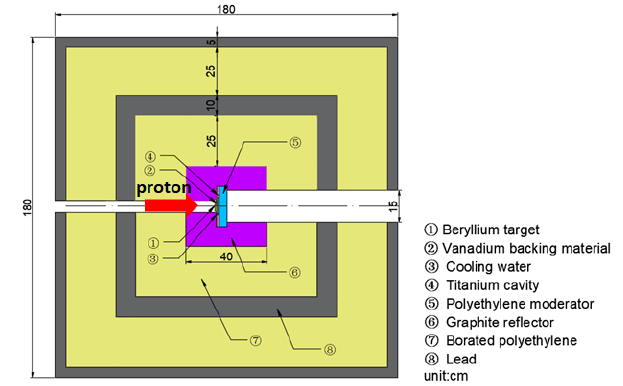
Fig. 1. RANS target